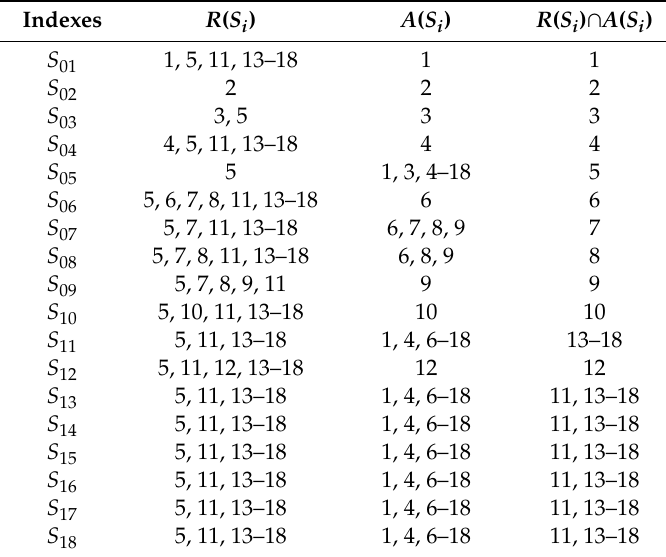
Table 4. Layer 1 partition of R .